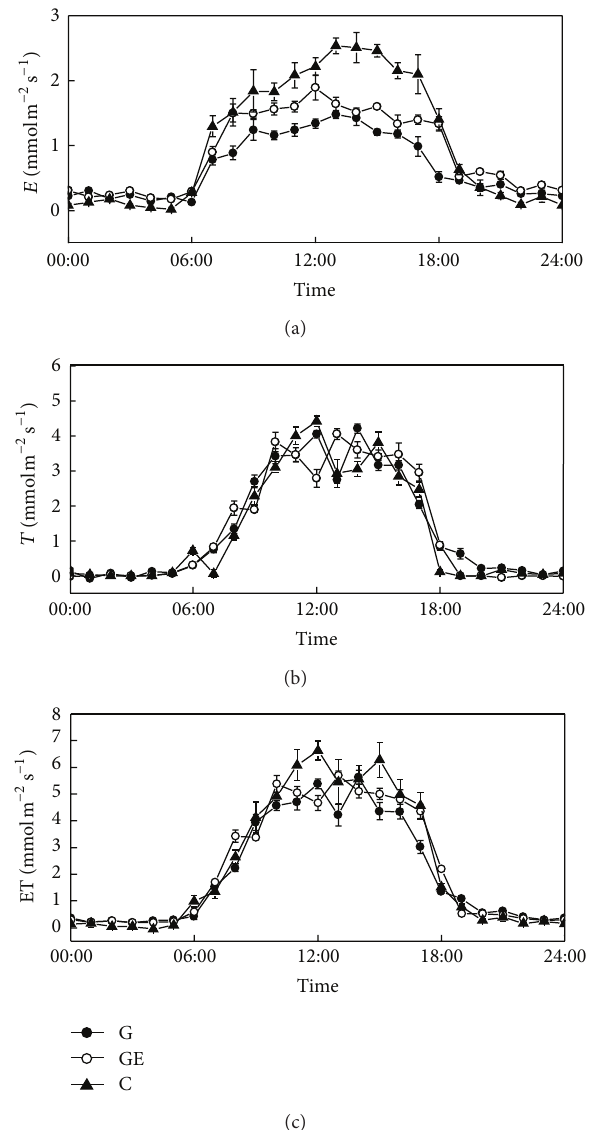
Figure 3: Daily dynamics of vapor exchange composition of different land uses during the peak growing period. (a) Evaporation (E); (b) transpiration (T); (c) evapotranspiration (ET). Error bar was